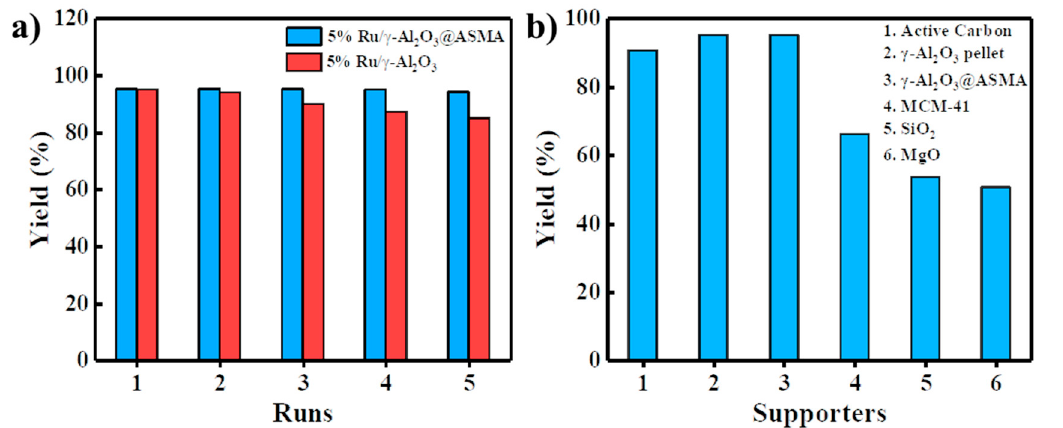
Figure 7. ( a ) Catalytic reusability of 5%Ru/ γ -Al 2 O 3 @ASMA and 5%Ru/ γ -Al 2 O 3 ; ( b ) peer comparison with different supports. Reaction condition: Catalyst: 2 g; temperature: 120 °C, H 2 pressure: 5 MPa; agitation rate: 600 rad/min; solution concentration: 20 wt% aqueous glucose, 50 g; reaction time: 2 h.